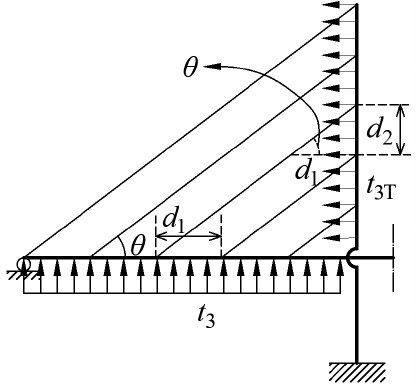
Figure 4. Parameters of membrane tension for the stay cable.